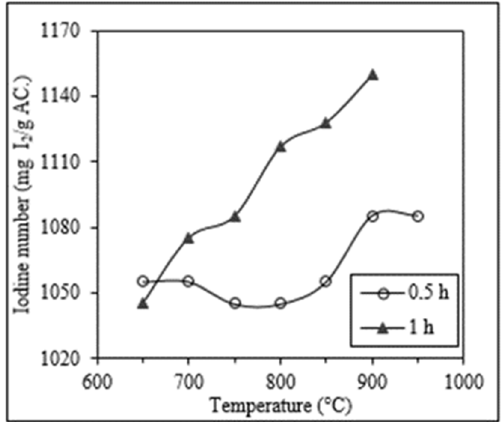
Figure 3. Influence of the reactivation time (0.5 and 1 h) on the iodine number (mg I 2 /g AC) of a SAC washed with H 2 SO 4 (30% v / v at 50 °C) subjected to a thermal reactivation at different temperatures (from 650 °C to 950 °C).